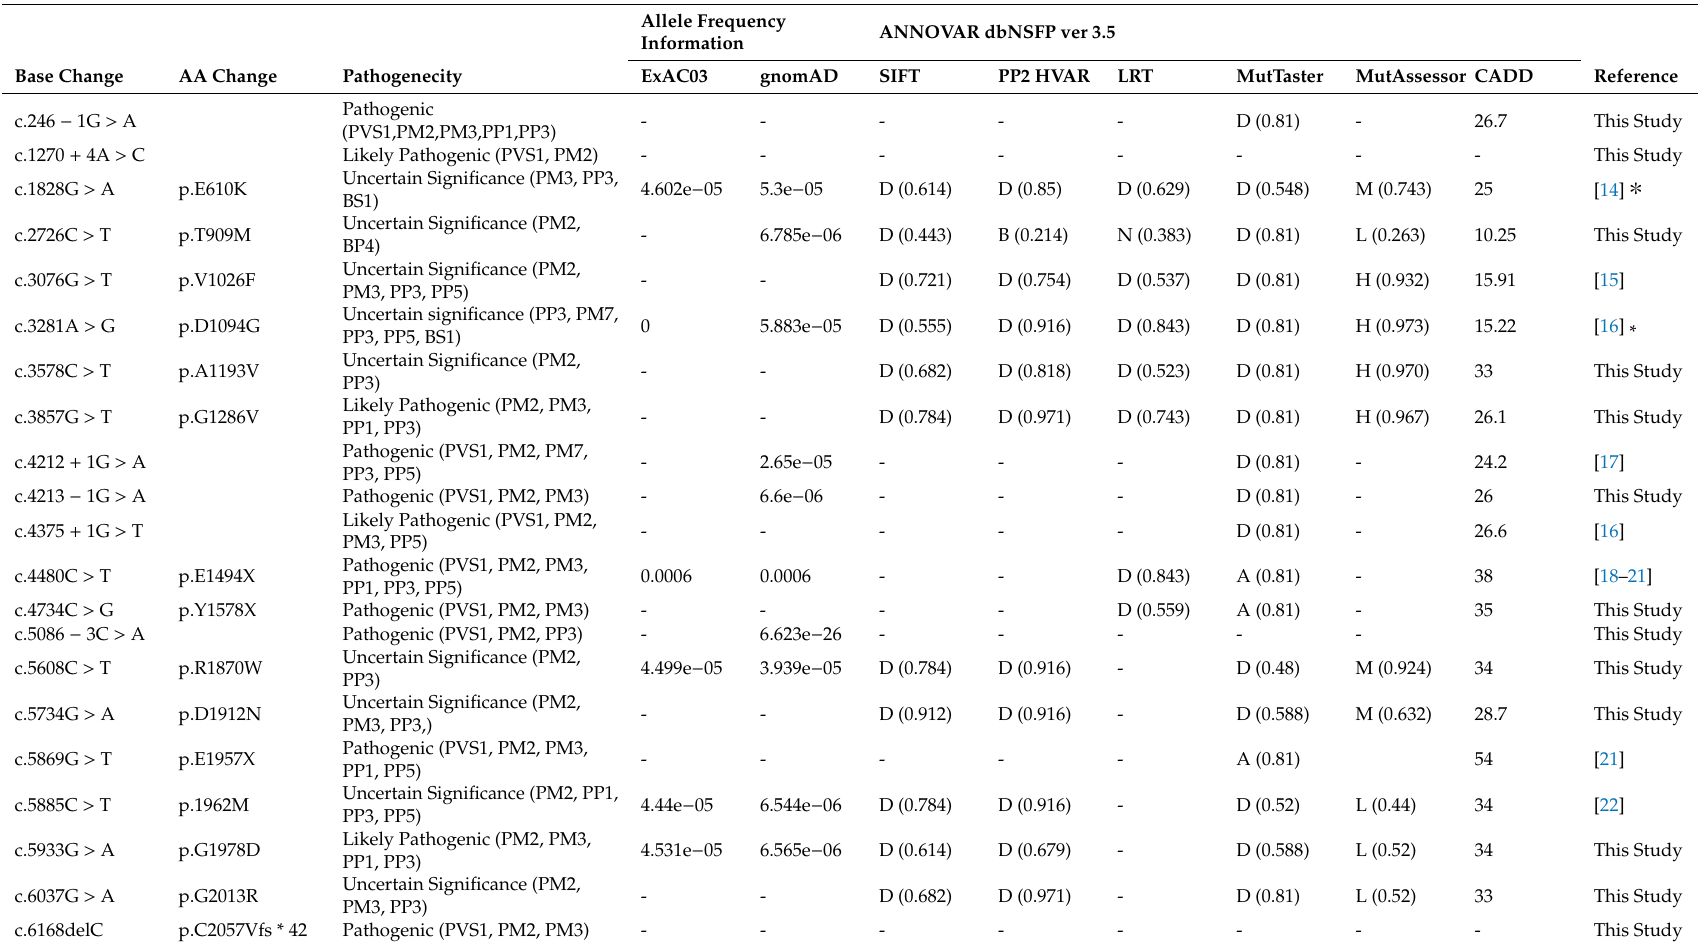
Table 1. All possibly pathogenic LOXHD1 gene variants identified in this study (NM_144612).